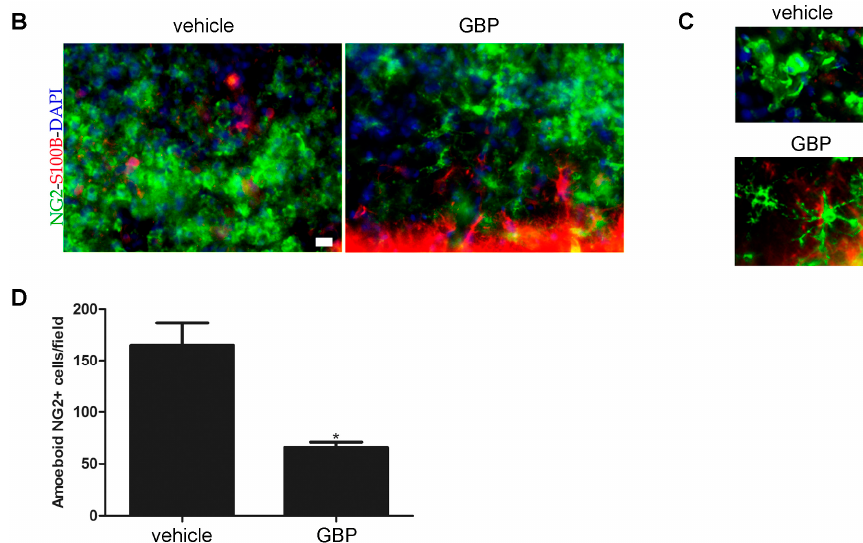
Figure 6. Gabapentin treatment reduces macrophage infiltration in SE animals. ( A ) Representative images showing the reduction in amoeboid NG2-immunoreactive infiltrating macrophages (green) in the piriform cortex of gabapentin (GBP) or vehicle-treated SE animals after 7DPSE. Counter staining with astroglial marker S100B (red) and DAPI nuclear staining (blue) are shown. Yellow color shows overlapping of both markers. Scale bar: 30 µ m. ( B , C ) Higher magnification images showing the change in NG2+ cells morphology from the macrophage-like amoeboid phenotype in 7DPSE vehicle-treated animals to the typical NG2+ oligodendrocyte precursor (OPC) stellated staining observed in GBP-treated animals. Scale bar: 15 μ m. ( D ) Quantitative analysis of amoeboid NG2+ cells in the GBP- and vehicle-treated animals after 7DPSE in the piriform cortex. Significance was evaluated by Student- t test (* p < 0.05), data are expressed as mean ± SEM.